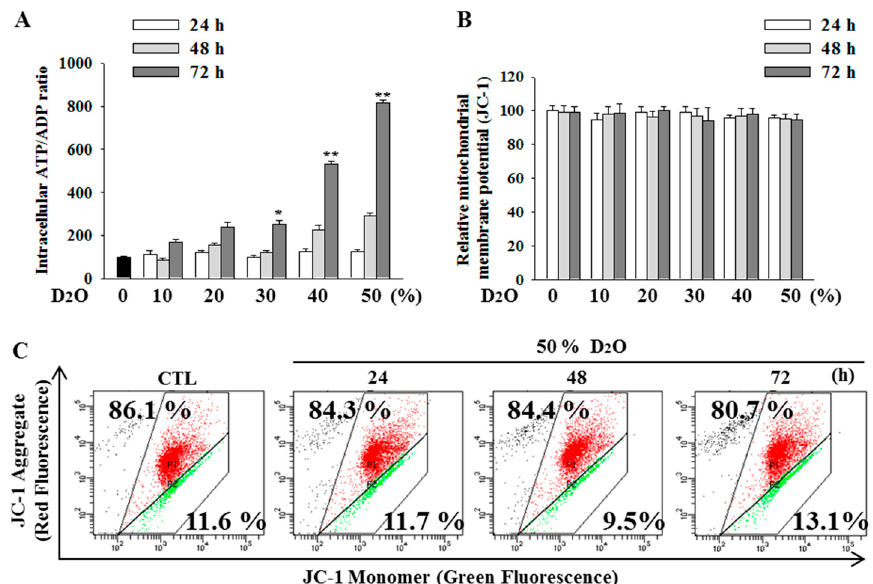
Figure 4. The [ATP]/[ADP] ratio increased after treatment of HSC-T6 cells with deuterium oxide (D 2 O) for 24, 48, or 72 h. ATP and ADP levels were measured and expressed as the [ATP]/[ADP] ratio ( A ). Mitochondrial membrane potential was measured with the JC-1 dye ( B , C ). ** p < 0.01 or * p < 0.05 as compared with the control. Data are presented as mean ± SD (n = 3).